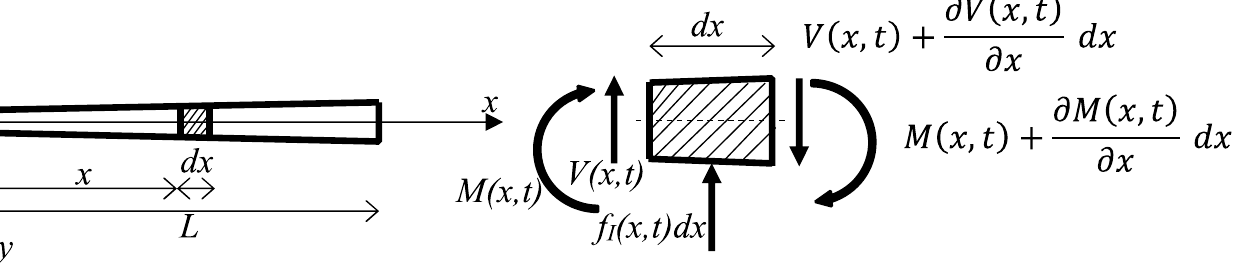
Figure 6. Internal forces acting on an infinitesimal Euler–Bernoulli beam. Given the mass of the accelerometer (0.89 kg), of the vibrodyne (0.93 kg), and of the beam (8.82 kg), it is necessary to take into account the exact position of these masses also in the analytical model. For this reason, the Euler–Bernoulli beam Equation (7) has been integrated considering the three different fields separated by the two lumped masses of the vibrodyne and of the accelerometer, see Figure